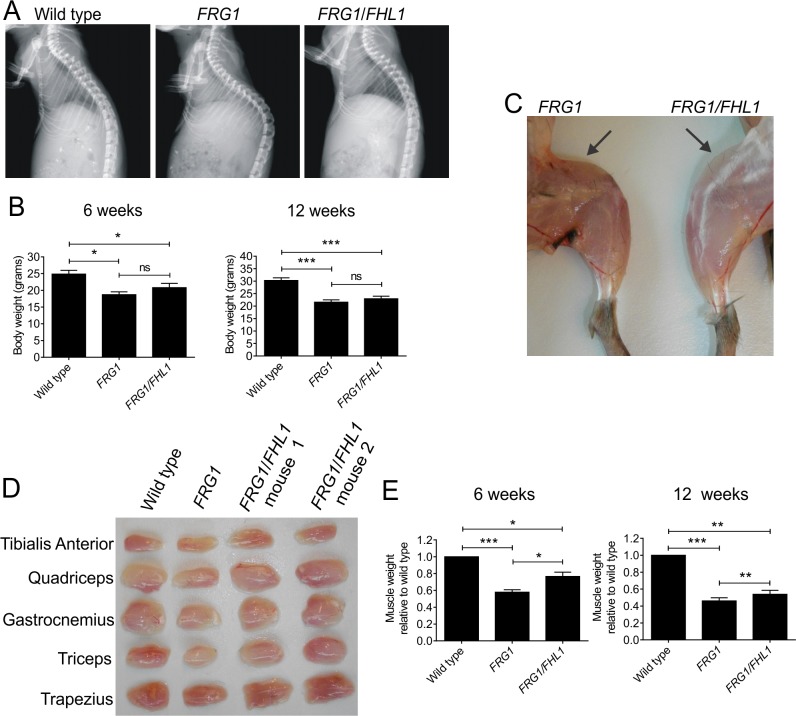
FHL1 reduces muscle wasting in dystrophic FRG1 mice.(A) Representative X-ray images of the spine of mice from the indicated genotypes. (B) Whole body weight in 6-week-old mice; wild-type (n = 10); FRG1 (n = 6); FRG1/FHL1 (n = 9); and 12-week-old mice; wild-type (n = 11); FRG1 (n = 12); FRG1/FHL1 (n = 14). (C) Representative image of skinned hind limbs from FRG1 and FRG1/FHL1 mice. Arrows point to the quadriceps muscle to show the difference in muscle mass between the FRG1 and FRG1/FHL1 mice. (D) Representative images of various muscles dissected from wild type, FRG1 and FRG1/FHL1 mice. (E) Relative muscle weight from 6-week-old mice and 12-week-old mice. Data represents an average of the combined weights from 4 muscle groups (n = 6–10 mice per genotype for the tibialis anterior, quadriceps, triceps and trapezius) and is expressed relative to wild type muscle weight. Data represent the mean ± SEM; *p< 0.05; **p<0.005; ***p<0.0005 determined by two-tailed Student’s T-test.